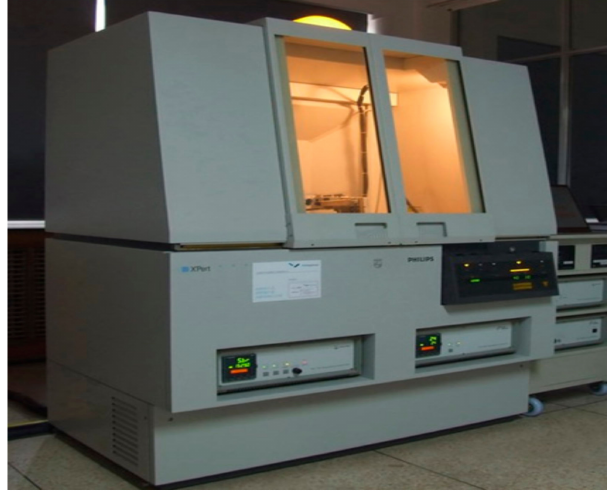
Figure 3. X’Pert Pro X-ray di ff raction